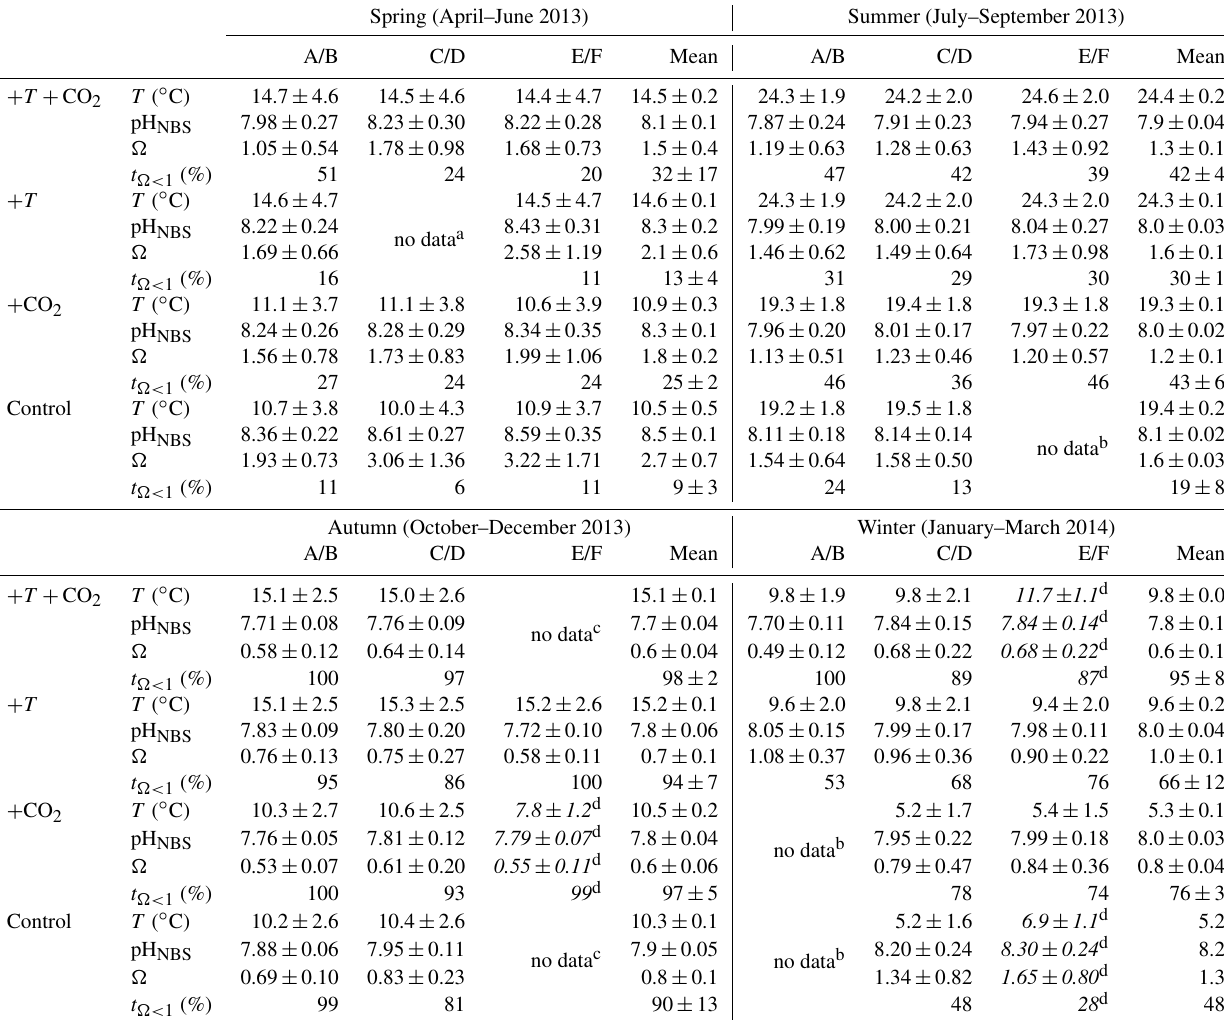
Table 1. Average water data of the four treatments in the four seasonal